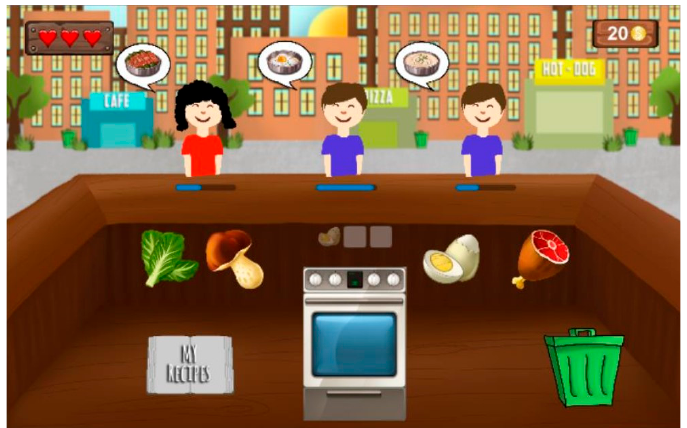
Figure 6. Screen of the gameplay.